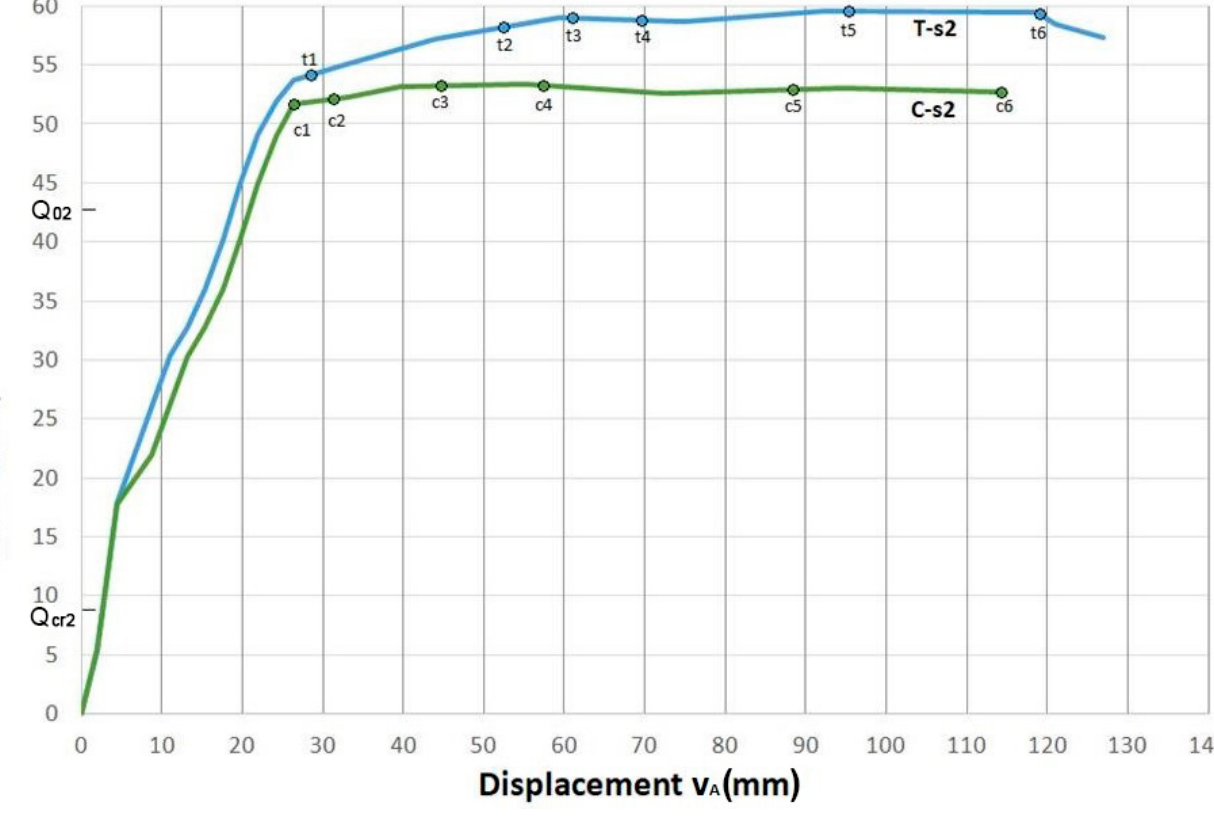
Figure 6. Displacement of the measuring point A in the midspan of beams Series 2 with the proposed truss reinforcement T-s2 and with conventional reinforcement C-s2 .